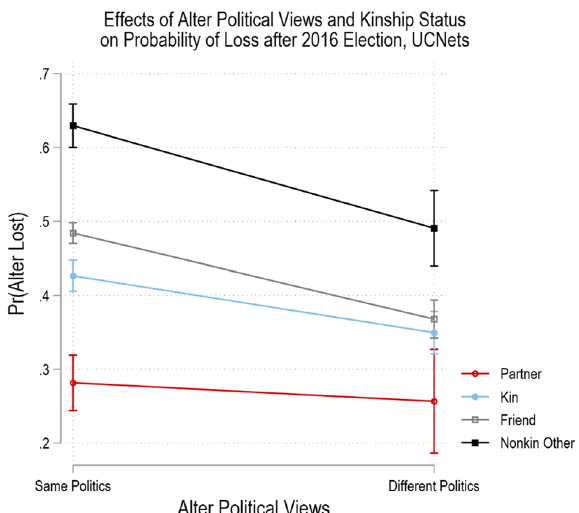
Fig. 1 Effects of alter political views and kinship status on probability of loss after the 2016 Election,